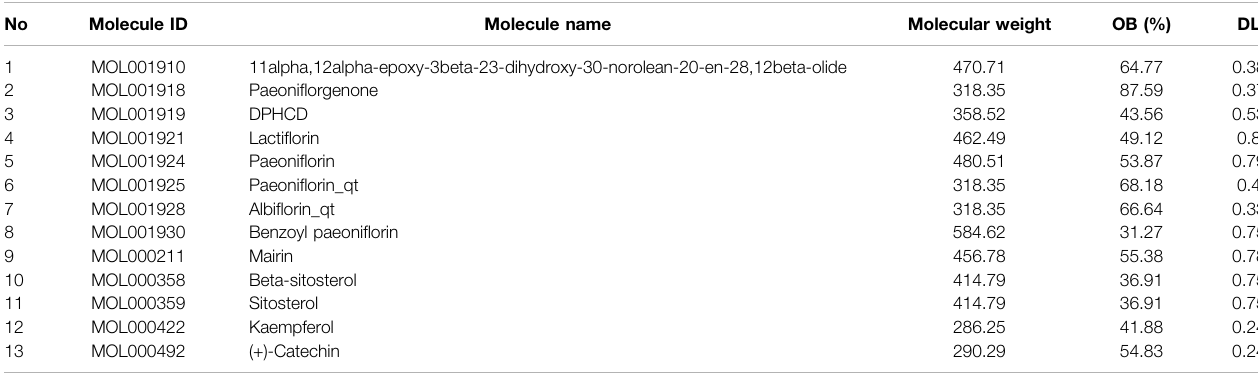
TABLE 1 | Characteristics of active ingredients in WP. Molecule ID Molecule name